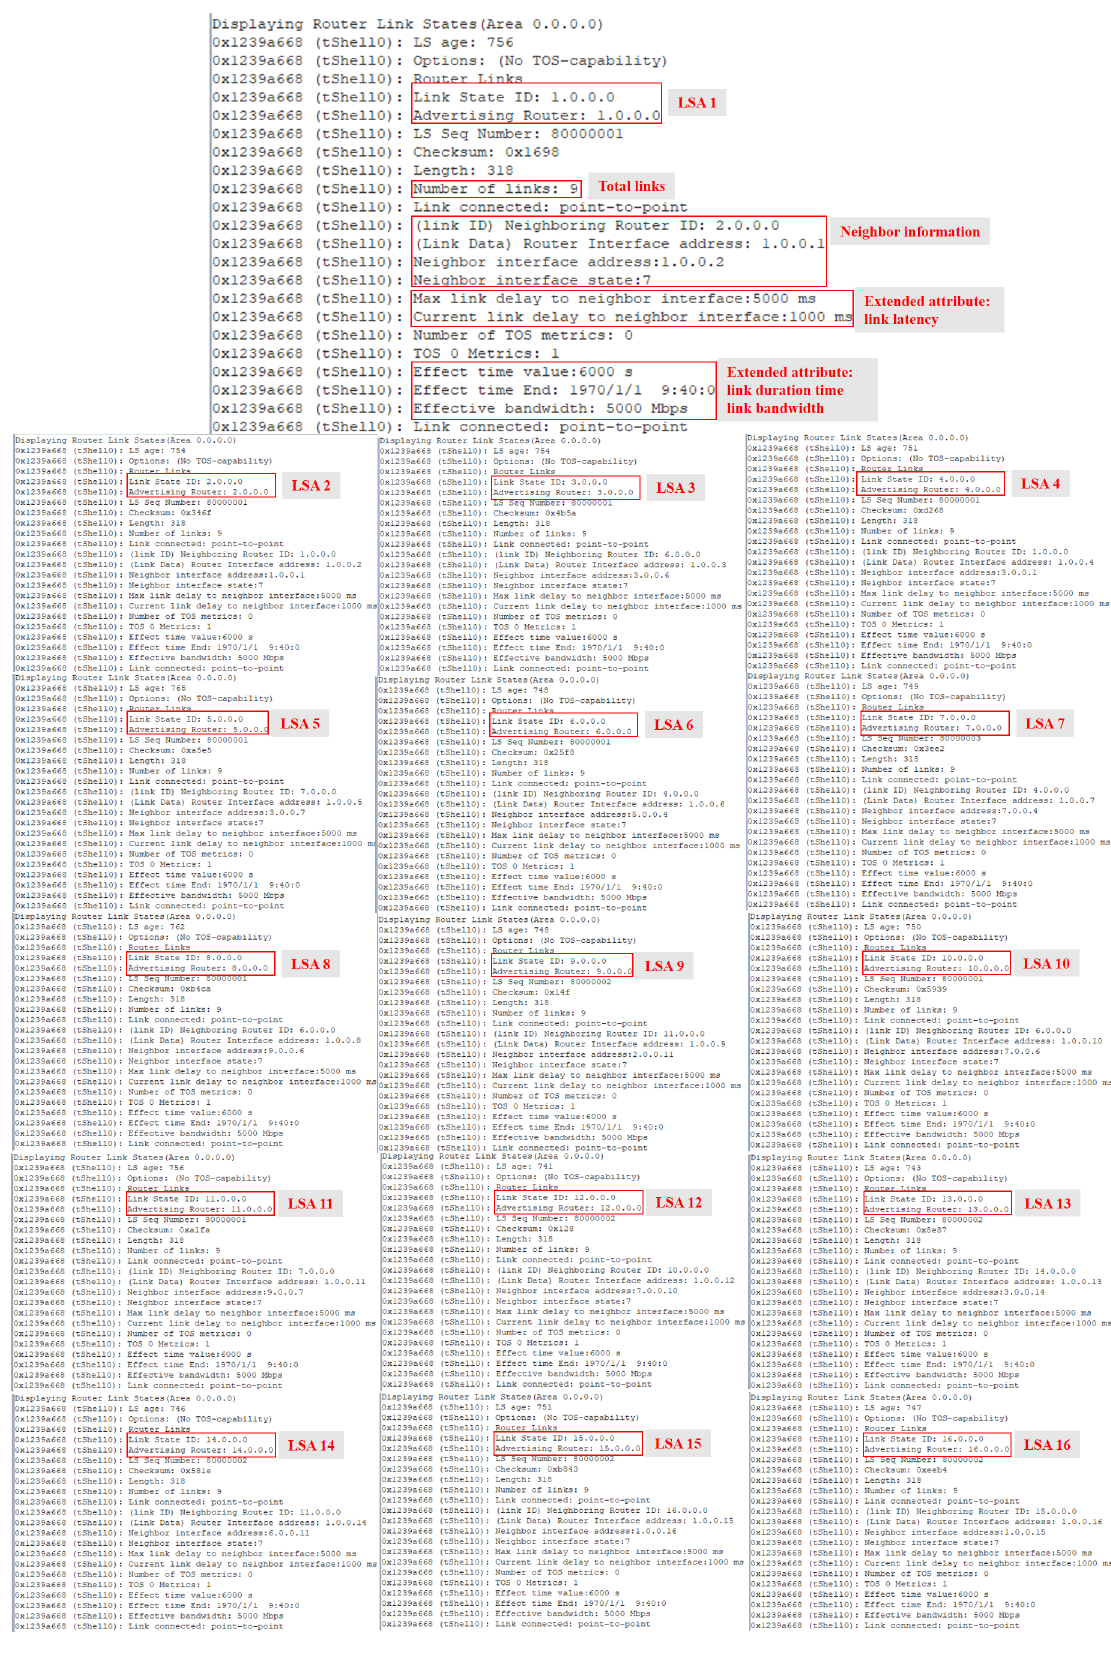
Figure 9. Link-state database of optimized OSPF in node vx_simulator_01 (SCID